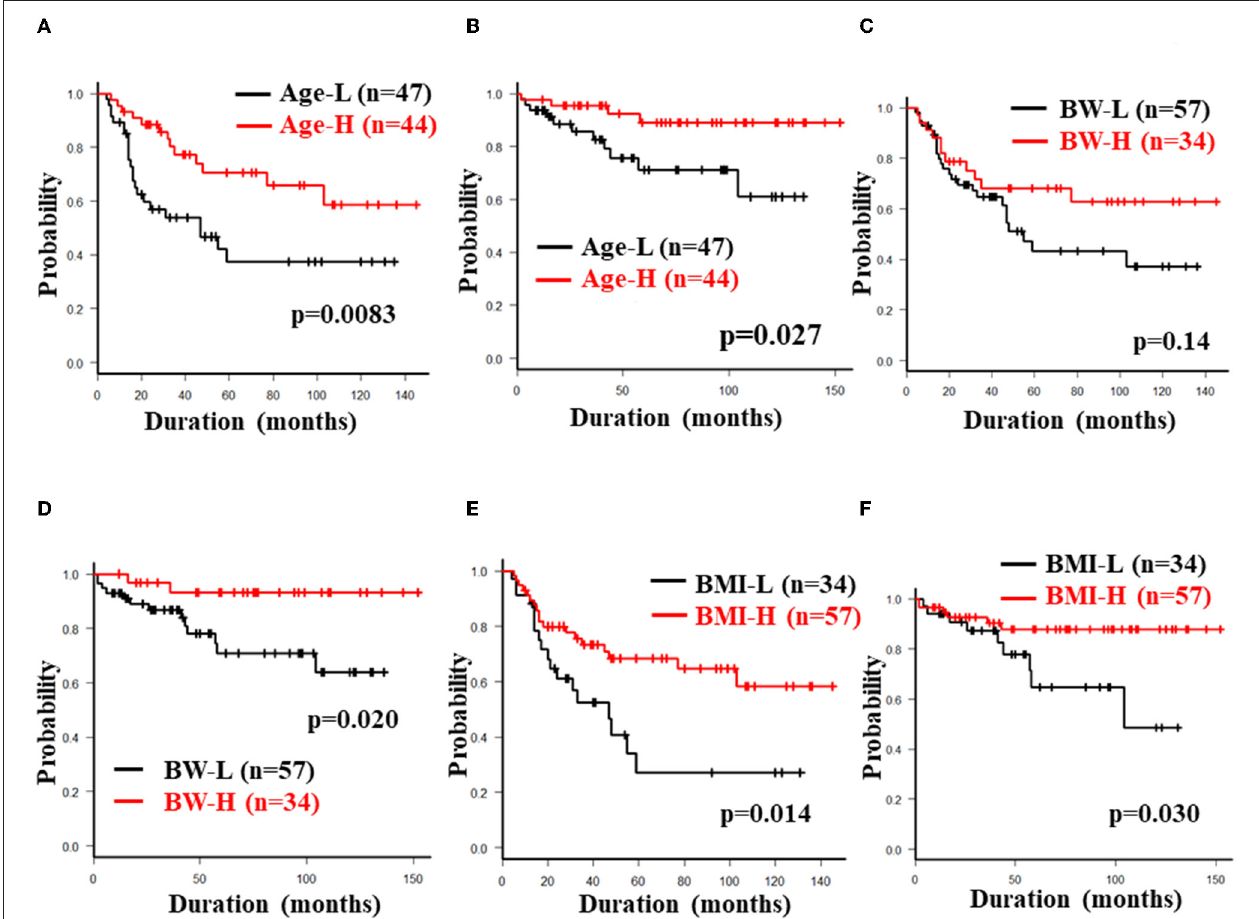
FIGURE 4 | Cumulative secondary failure-free and bowel resection-free rates classified according to age at induction, BW and BMI. The figures show the cumulative secondary failure-free rate (A) and bowel resection-free rate (B) classified according to the age at induction, the cumulative secondary failure-free rate (C) and bowel resection-free rate (D) classified according to BW, and the cumulative secondary failure-free rate (E) and bowel resection-free rate (F) classified according to BMI.